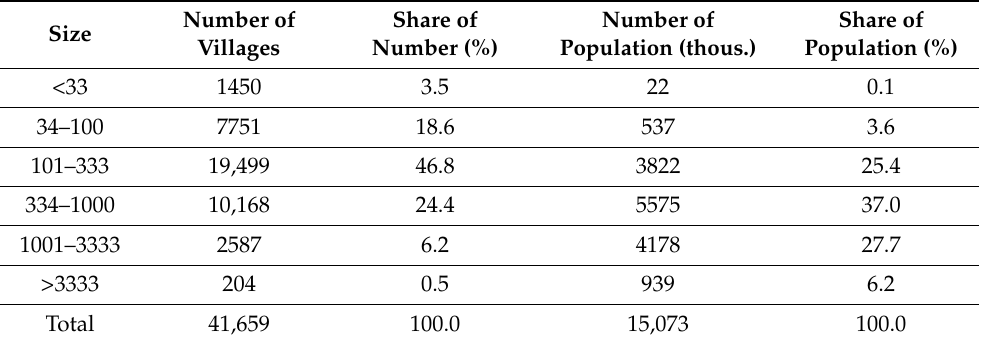
Table 4. Size structure of villages in Poland, for the year 2009.